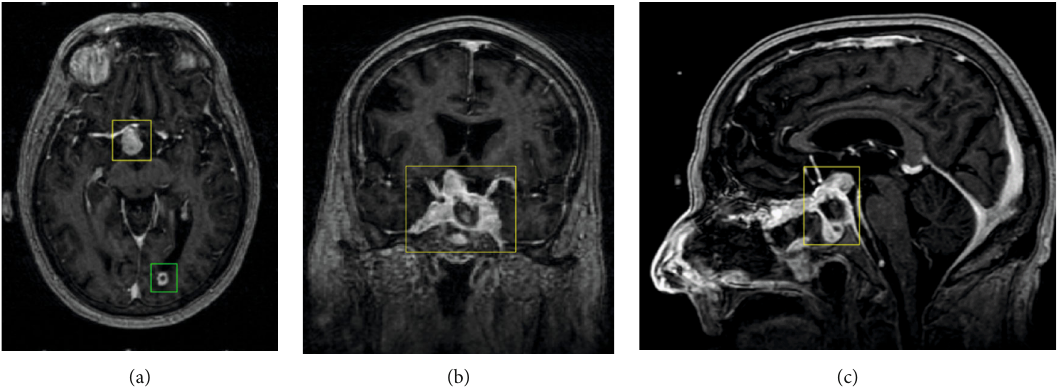
Figure 3: Radiographic imaging of tumor progression postoperative. T1-weighted sequence magnetic resonance imaging with double contrast presented in axial, coronal, and sagittal planes, respectively. The mass has undergone subtotal resection (a – c). The left occipital lesion is stable (a). The suprasellar lesion measures 2 : 7x1 : 4 x2 : 0 cm with total volume calculated at 4.6 mL. Yellow boxes highlight the tumor of interest. Green box highlights occipital lesion.